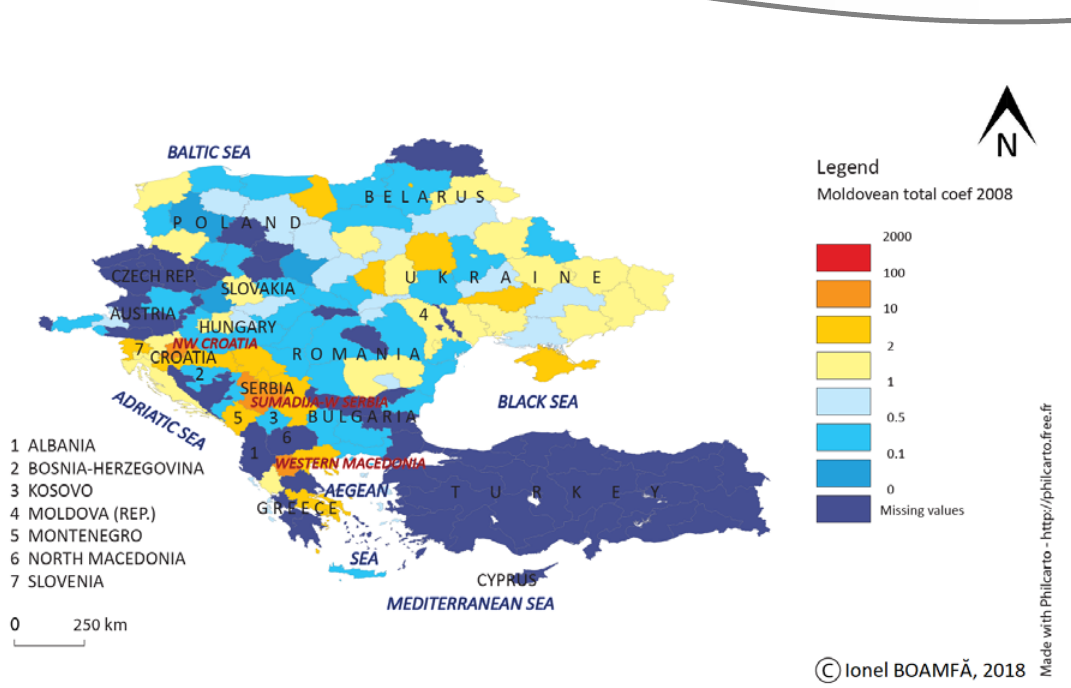
Figur e 16 . G eographical repartition of the anthroponym Băcean. Coef. of spatial distribution